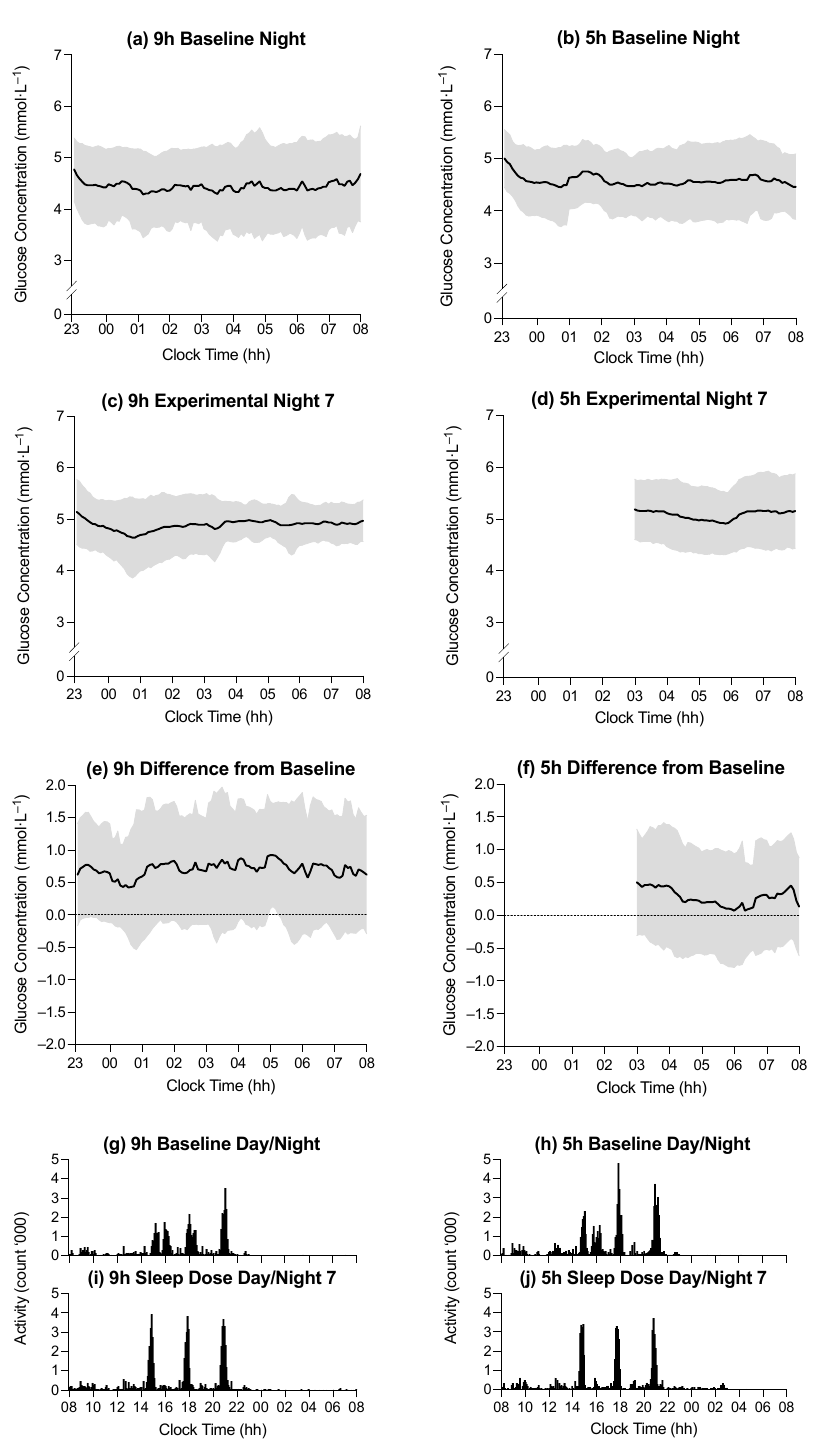
Figure 2. ( a – d ) Average glucose concentration (black line) in the 9 h condition at baseline, the 5 h condition at baseline, the 9 h condition on experimental night seven, and the 5 h condition on experimental night seven, respectively. ( e , f ) Difference in average glucose concentration between baseline and experimental night seven in the 9 h and 5 h conditions, respectively. Horizontal axes indicate clock time (hh = hours), and vertical axes represent glucose concentrations (mmol·L − 1 ). Shaded regions indicate ± SD. ( g , h ) Mean activity profiles in the 9 h condition during baseline, the 5 h condition during baseline, the 9 h condition during experimental day/night seven, and the 5 h condition during experimental day/night seven, respectively ( i,j ). Horizontal axes indicate clock time (hh = hours), and vertical axes represent mean activity counts (‘000).